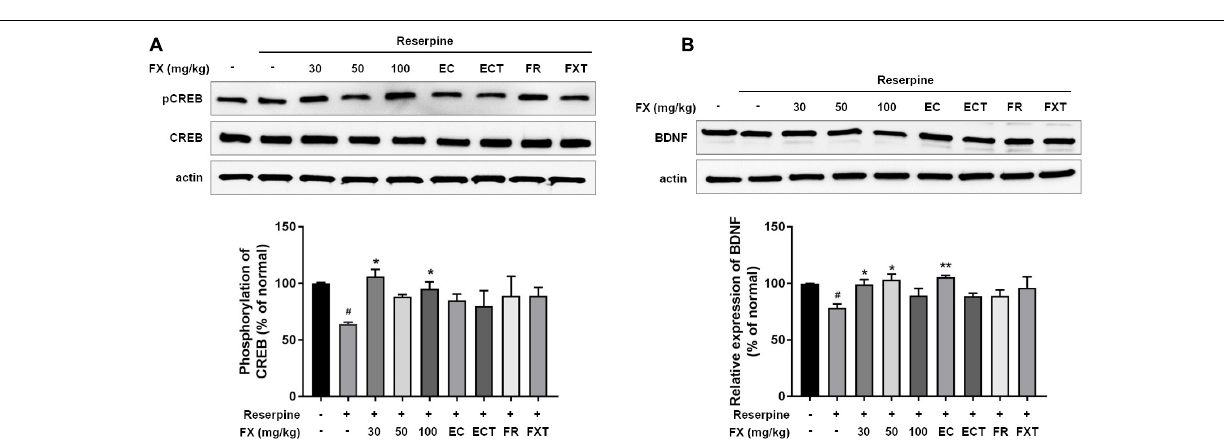
FIGURE 6 | Effect of FX extract and its components on the expression of pCREB/CREB and BDNF. (A) pCREB/CREB and (B) BDNF levels were measured in the hippocampus. FX extract significantly increased pCREB/CREB levels ( n = 3). FX extract EC significantly increased BDNF levels. # P < 0.05 vs. normal group; * P < 0.05 and ** P < 0.01 vs. reserpine